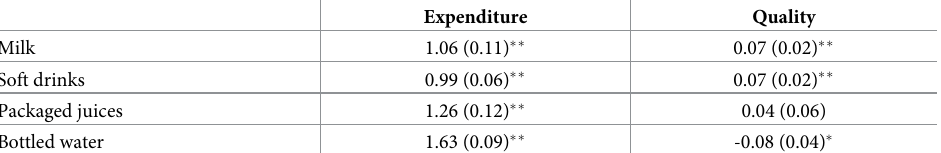
Table 4. Beverage expenditure and quality elasticity estimations and standard errors (SE) 1